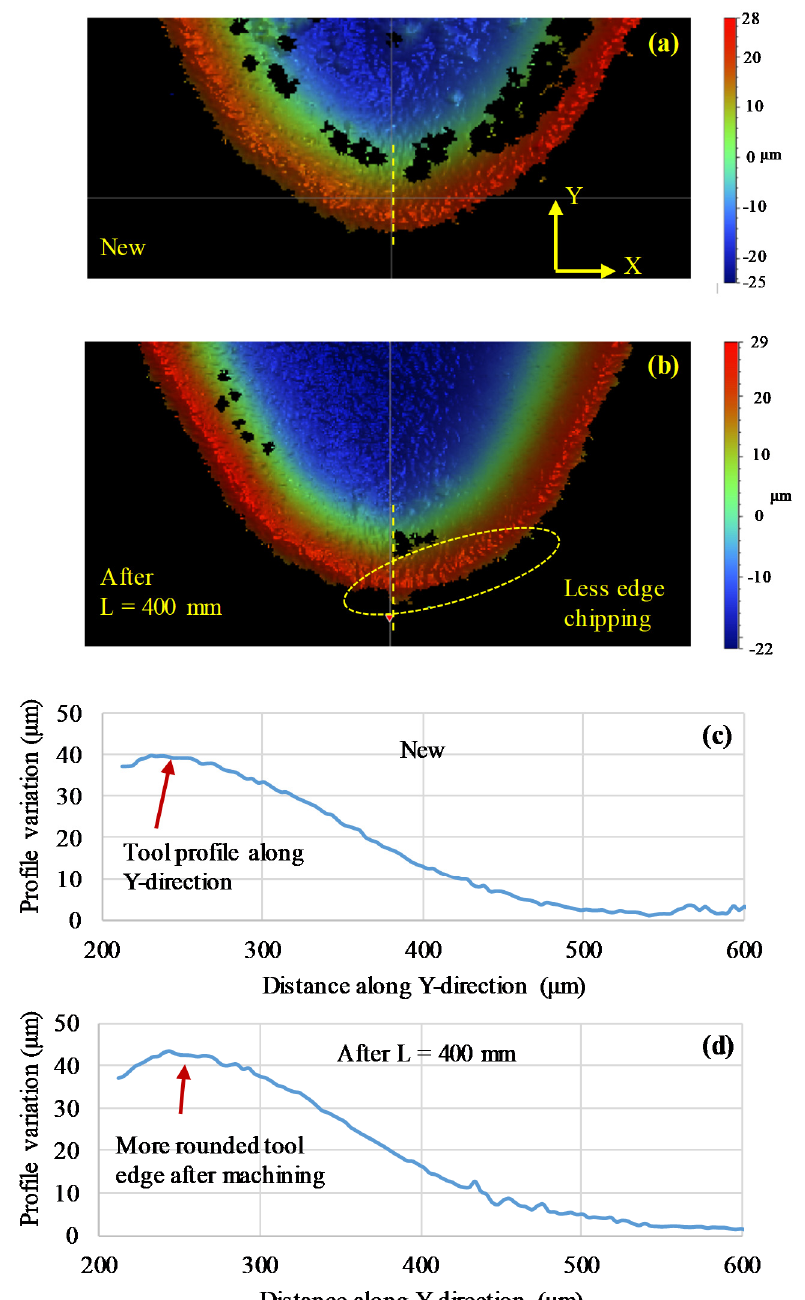
Figure 8. 3D scanned surfaces and 2D profiles of the wiper insert before and after use ( a ) 3D surface contour of a new insert; ( b ) 3D surface contour of a used insert after L = 400 mm; ( c ) 2D profile of new insert and ( d ) 2D profile of a used insert after L = 400 mm.